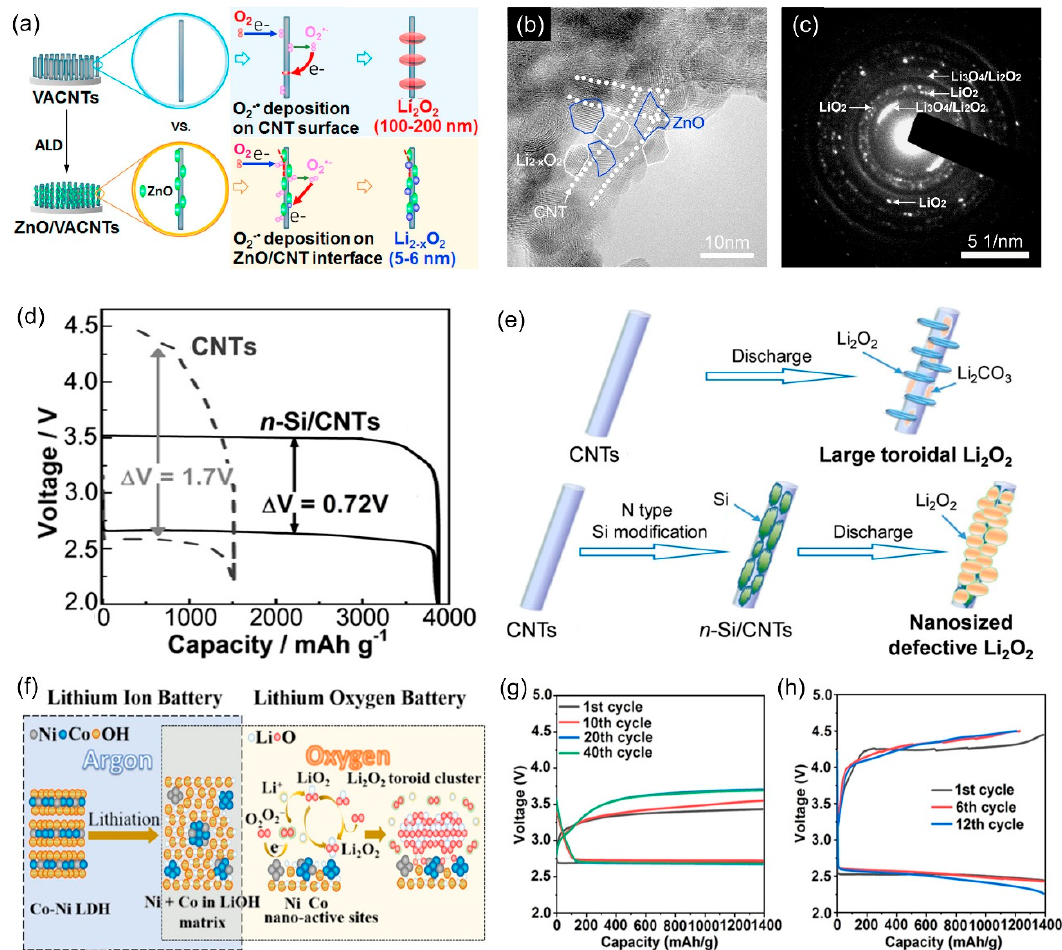
Figure 6. ( a ) Proposed mechanisms for electrochemical growth processes of discharge product on two different positive electrode (VACNTs and ZnO/VACNTs). ( b ) The high-resolution transmission electron microscopy (HRTEM) image along with ( c ) the corresponding SAED of the discharge products on ZnO/VACNTs. ( d ) The electrochemical performance of Li-O 2 batteries with CNTs positive electrode and n-Si coated CNTs positive electrode. ( e ) The schematic illustration of the product moderation and carbon protection by introducing n-type Si modification. ( f ) Schematic diagram of lithiated Co–Ni LDH with enhanced electrical conductivity network and highly exposed active sites. The cell performance of Li-O 2 batteries with ( g ) the lithiated Co–Ni LDH positive electrode and ( h ) the pristine Co–Ni LDH positive electrode. ( a – c ) Reproduced with permission from Ref. [104], copyright 2016, Elsevier. ( d,e ) Reproduced with permission from Ref. [117], copyright 2018, American Chemical Society. ( f – h ) Reproduced with permission from Ref. [122], copyright 2018, American Chemical Society.